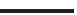
Nuclear accent on V Total 116 116 232